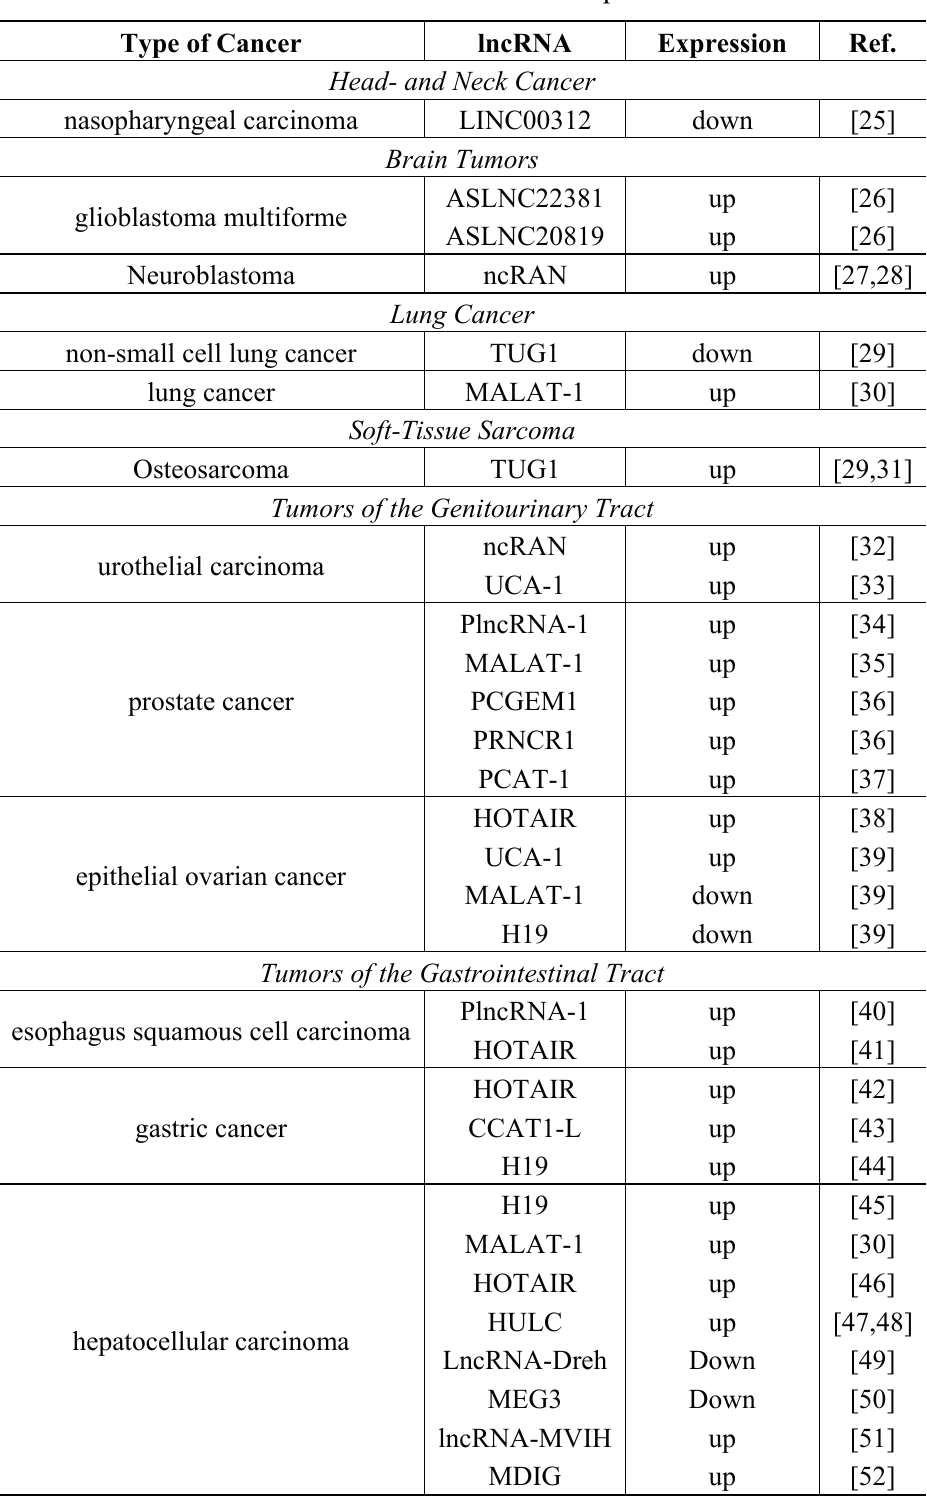
Table 1. Cancer and lncRNA